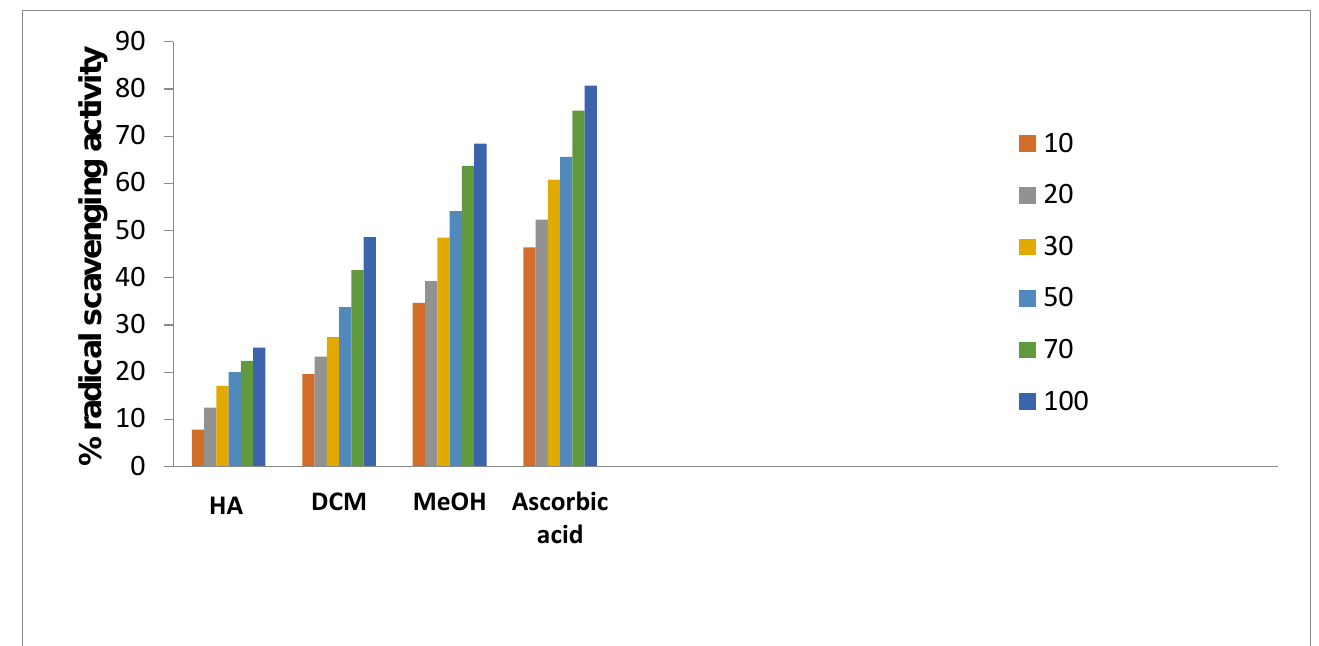
Figure 6. DPPH free radical scavenging activity of different extracts. [HA: hexane, DCM: di- chloromethane, MeOH: methanol extracts of N. mexicana Zucc. and ascorbic acid is a positive con- trol].